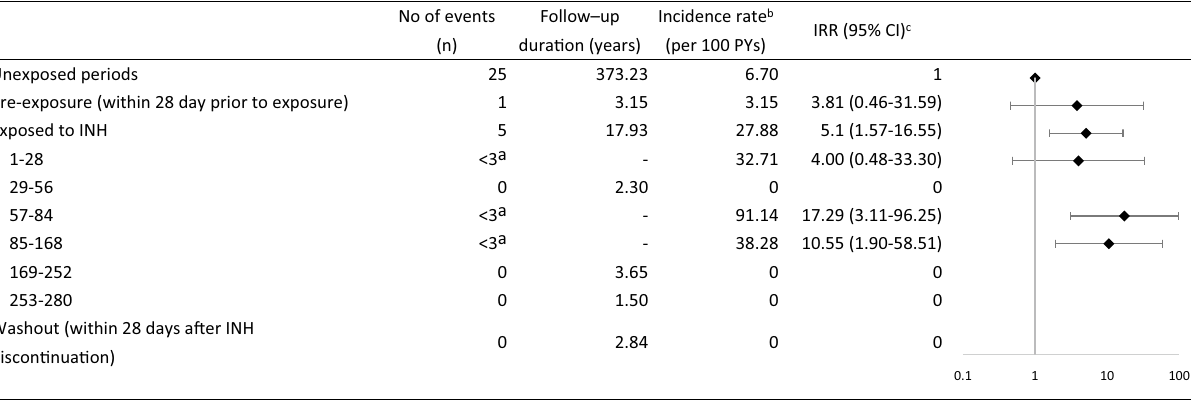
Table 2. Risk of severe hepatitis before and after treatment with isoniazid (n = 31). a Numbers less than 3 considered as identifiable. b Incidence rate was reported as per 100 person-years. c Incidence rate ratios (IRR) were adjusted for covariates listed in Table